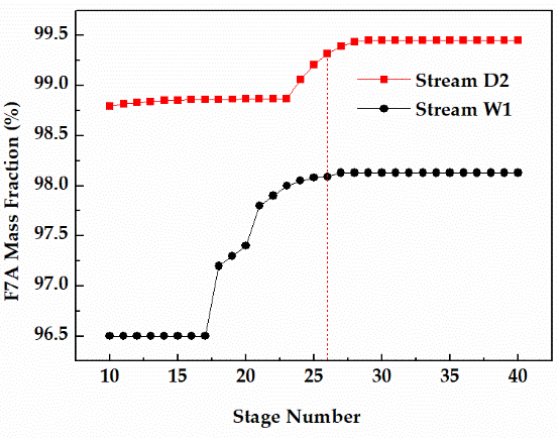
Figure 8. Effect of stage number on F7A mass fraction in stream W1 and D2.